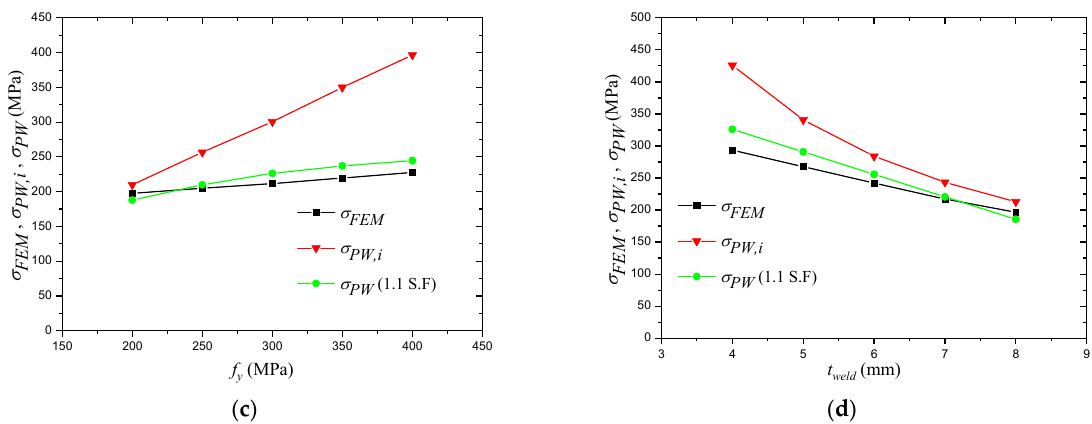
Figure 21. Parameters with significant influence on the resultant stress of the welded corner. ( a ) Influence of the plate width to thickness ratio ( W / t ); ( b ) Influence of the short plate to long plate ratio ( W sh / W lo ); ( c ) Influence of the yield strength of steel ( f y ); ( d ) Influence of the weld throat thickness ( t weld ).